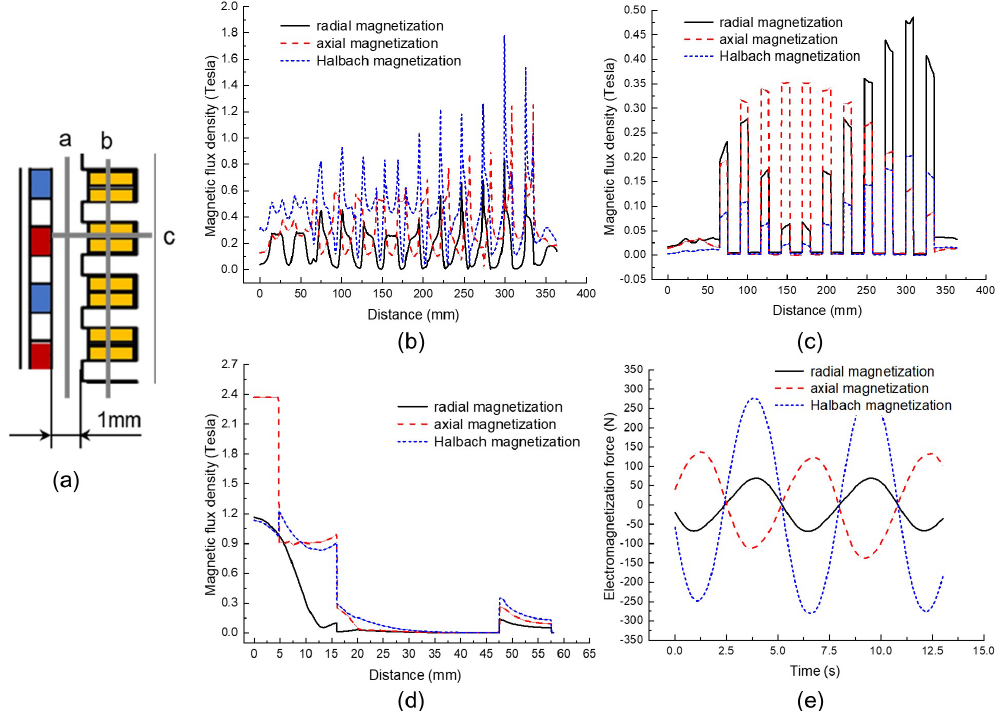
Figure 9. (a) Auxiliary lines from different directions, (b) magnetic flux density at different positions of air gap (line a), (c) magnetic flux density at different positions of tooth tip (line b), (d) flux density in the height direction of yoke (line c), and (e) magnetization force of each magnetizing mode.